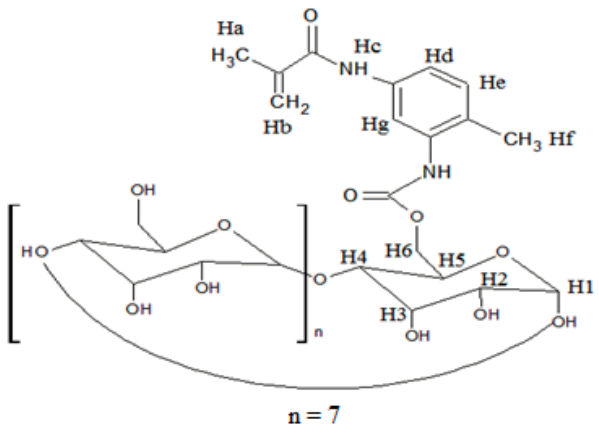
Figure 4. Formation of MAA- β -CD molecule